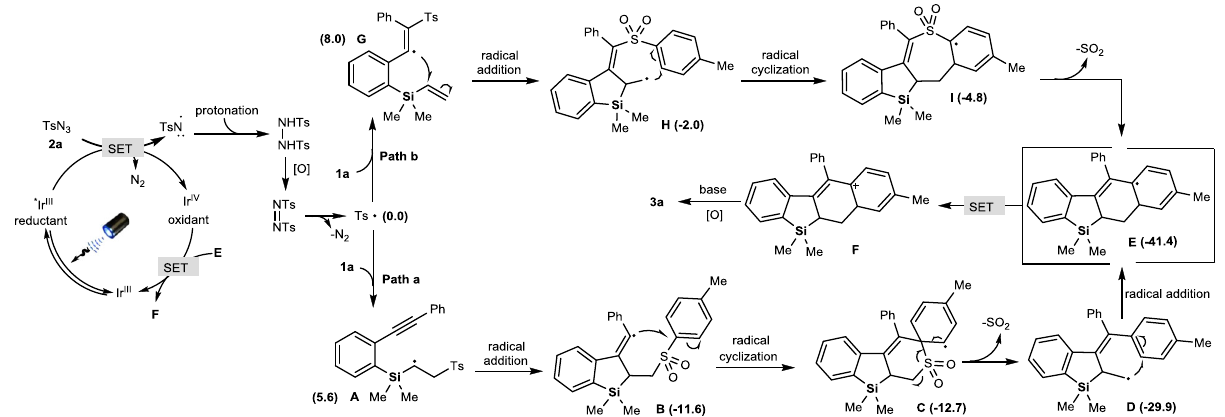
Fig. 8 Proposed reaction mechanism. Cycloaromatization of vinylsilanes with arylsulfonylazides via Path a and Path b.